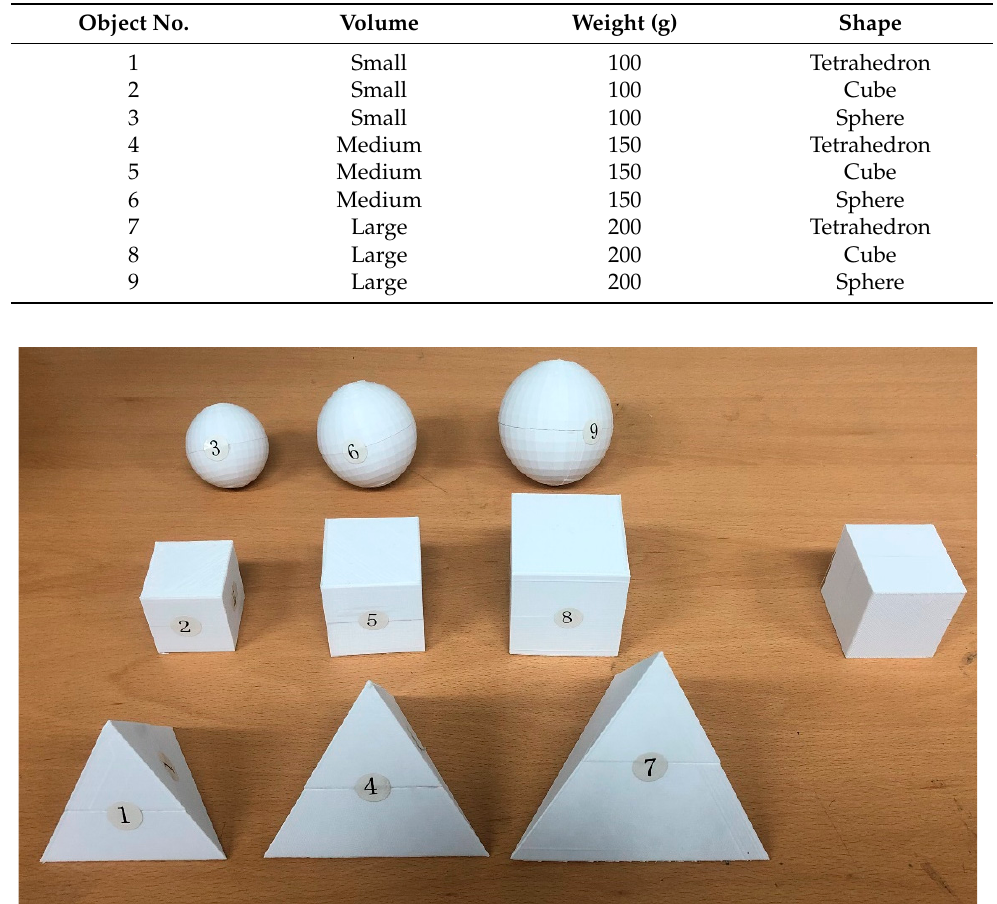
Table 3. Experimental conditions.